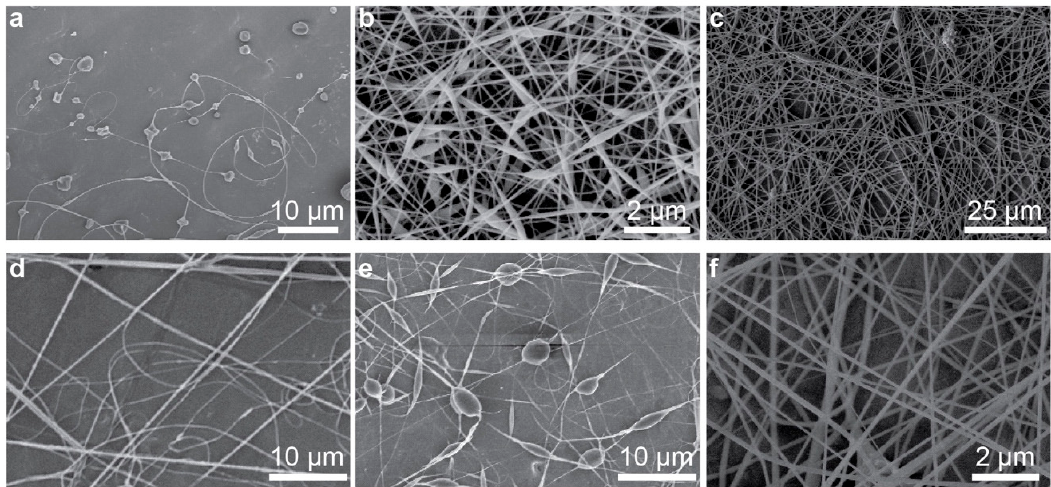
Figure 3. Array of nanofibers synthesized with a conventional benchtop electrospinner: ( a ) 4 wt.% CA in acetone / water, ( b ) 6 wt.% PVA in THF, ( c ) 10 wt.% PAN in DMF, ( d ) 6 wt.% PEO in water, ( e ) 15 wt.% PCL in TFE and ( f ) 15 wt.% PVDF in DMF / acetone.